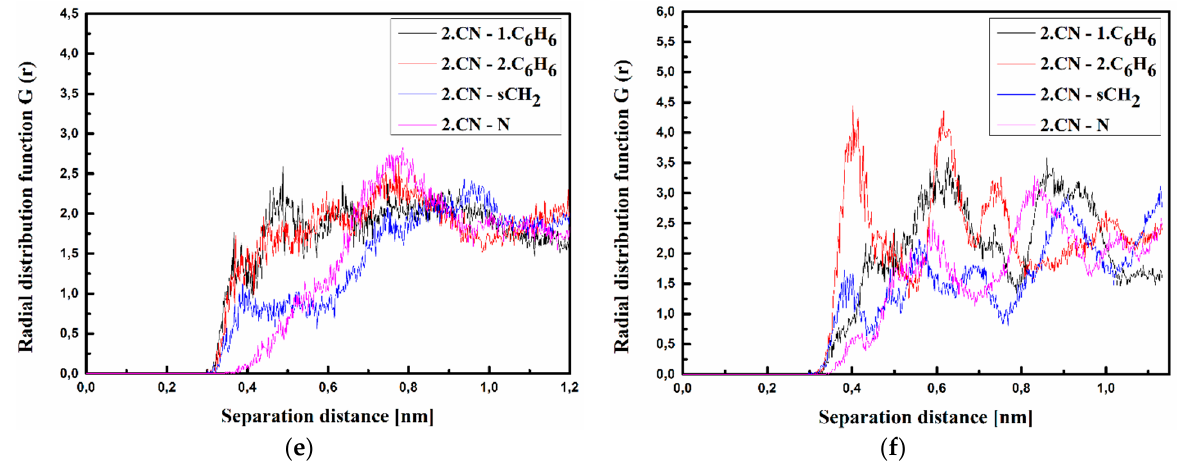
Figure 8. Partial RDFs calculated for distances between the center of mass of different moieties of the C molecule and different subunits of PVK at T = 500 K ( a , c , e ) and T = 300 K ( b , d , f ) for the thin film system. The RDFs are presented for carbazole group of C molecule and different subunits of PVK mer ( a , b ); for cyanovinyl CN1 at the side of the molecule C and different subunits of PVK mer ( c , d ); and cyanovinyl CN2 at the back of the molecule C and different subunits of PVK mer ( e , f ).